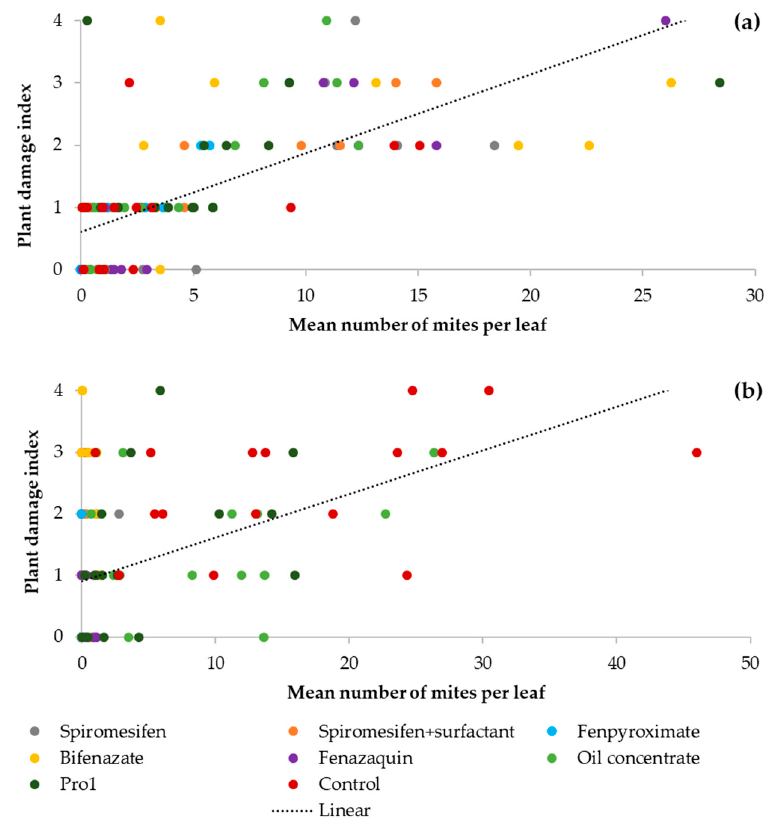
Figure 4. Relationship between the plant damage index and the number of mites per leaf for the pre-treatment (3-DBA) ( a ) and final measurements ( b ) at the end of the experiment 14 days after the 2nd and last miticide application (14-DAA). The plant damage index was used as follows: 0 = no bronzing; 1 = 1% ≥ 25% (low bronzing); 2 = 26% ≥ 50% (moderate bronzing); 3 = 51% ≥ 75% (high bronzing); and 4 = 76% ≥ 100% (severe bronzing) bronzed foliage.